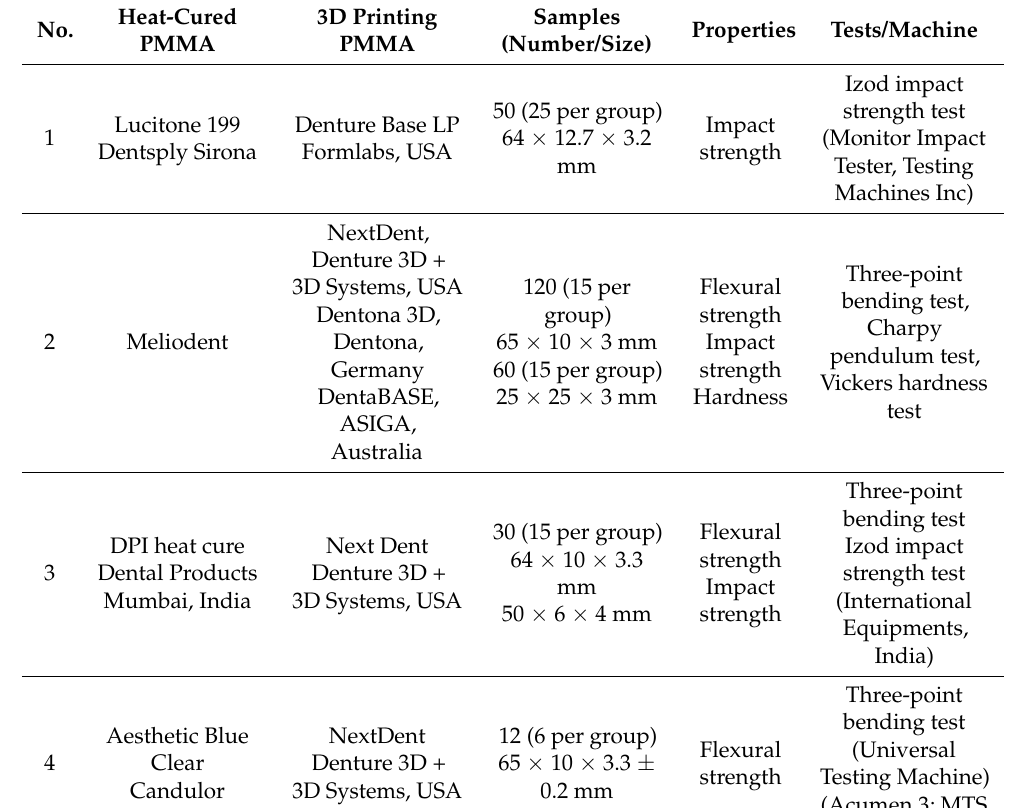
Table 2. Characteristics of the samples used in the studies